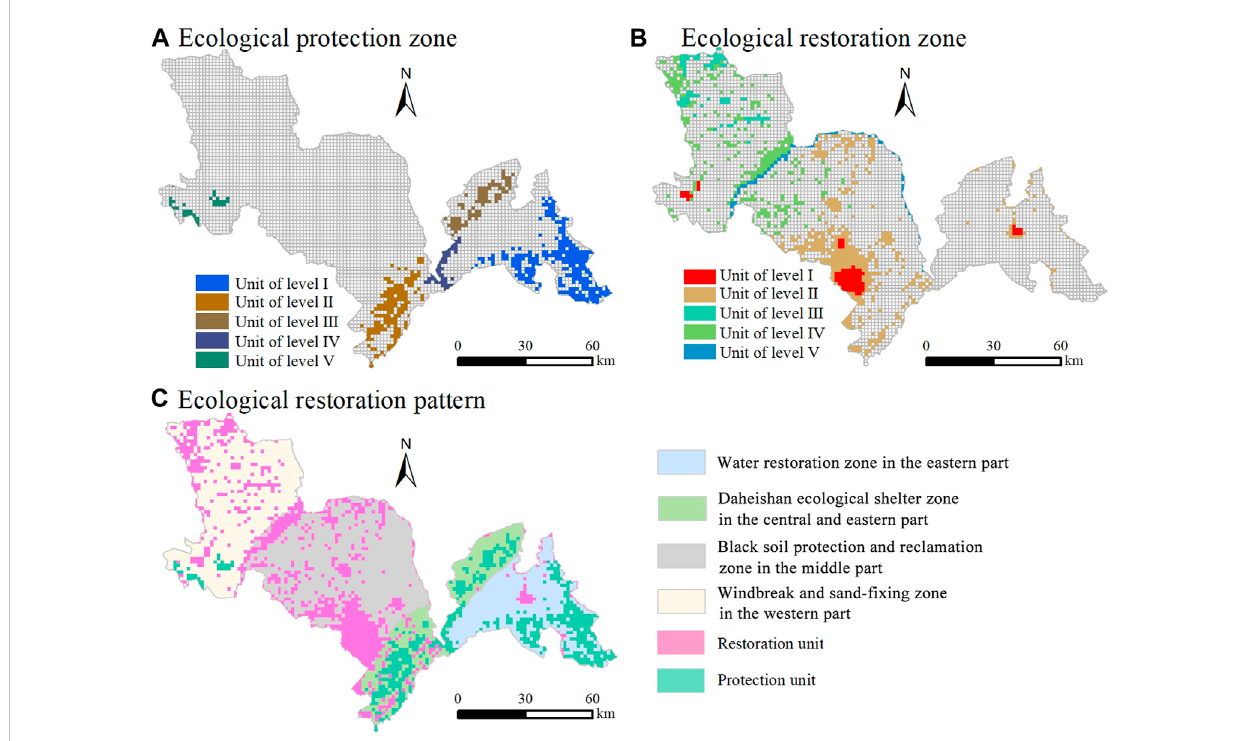
FIGURE 9 Delineation of (A) ecological protection and (B) restoration zones and (C) the ecological restoration pattern of Siping